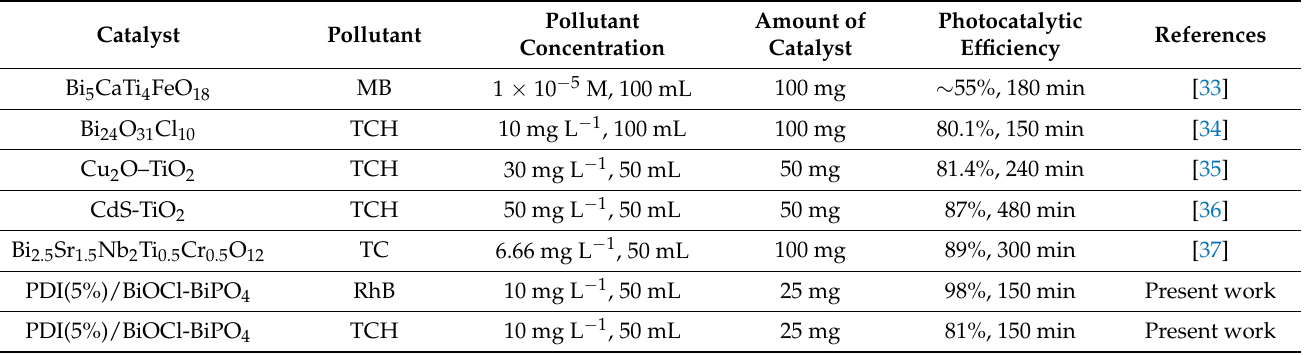
Table 1. Comparison of degradation efficiencies of different